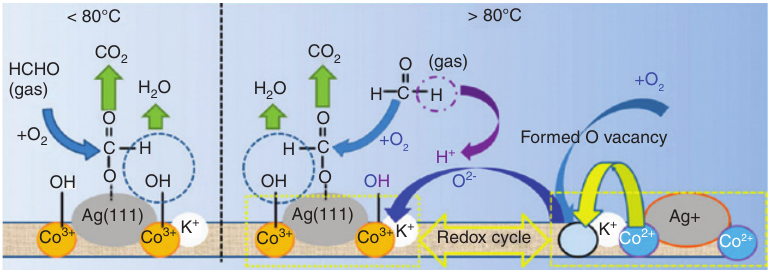
O catalyst. Reproduced from [105] with permission from the American Chemical 3 4